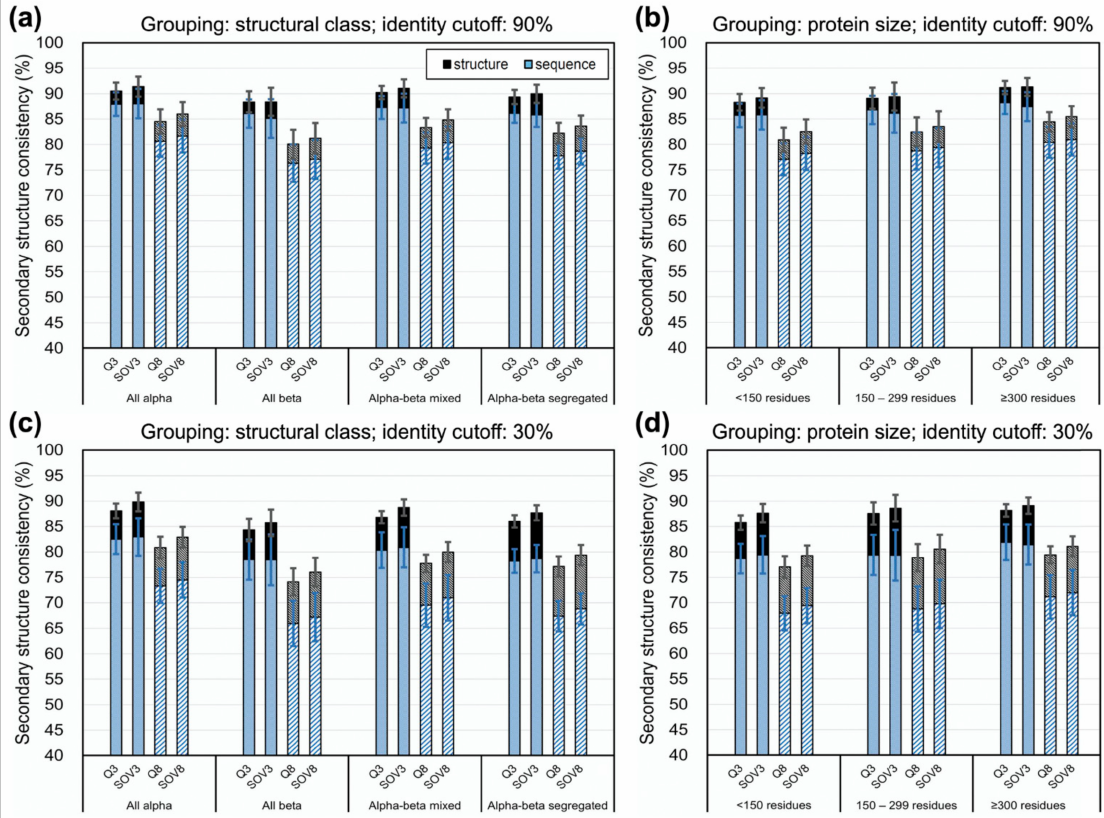
Figure 4. Secondary structural consistency for structural homologs of different structural classes or sizes. ( a ) The